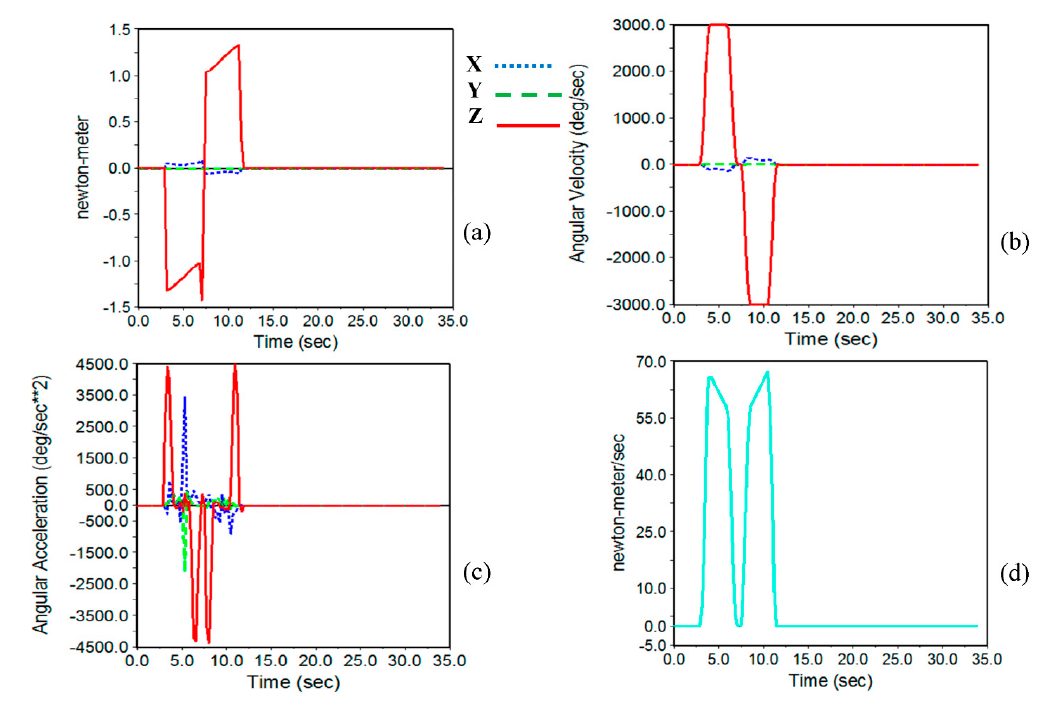
Figure 19. Results of ADAMS software simulation to determine the motor characteristics of the belly-cutting subset (10 fish per minute). In this figure, ( a – d ) are torque, angular velocity, angular acceleration, and required power respectively.